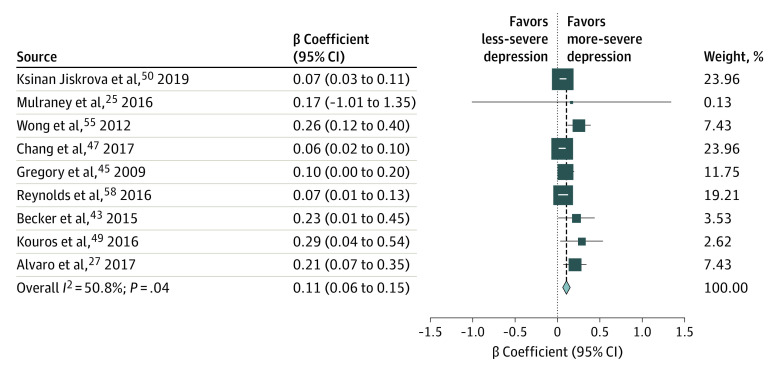
Forest Plot for Standardized β CoefficientWeights are from random-effects analysis.